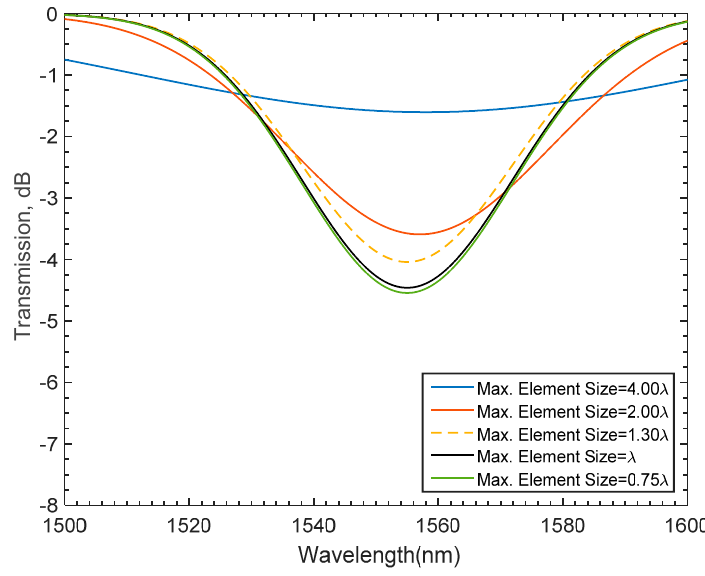
Figure 7. Gradual growth of LPFG in the modeled single mode fiber for different number of periods using free triangular mesh.